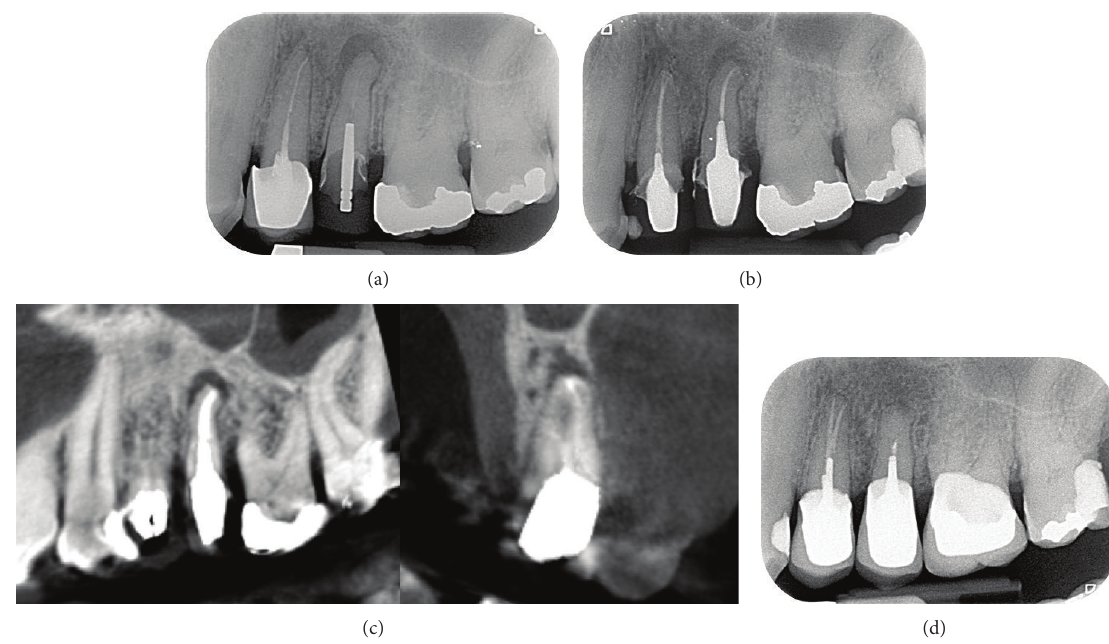
Figure 6: Contribution of the CBCT in the decision making process. (a) Periapical preoperative X-ray. Patient referred for the endodontic retreatmentof25.Notetheperiapicalradiolucencyon25.(b)Control12monthsaftertheretreatmentof25.Therearesymptomsandpersistent radiolucency on 25. The tooth was classified as “failure”. (c) CBCT coronal and sagittal slides of 25: a periapical surgery is indicated, (d) X-ray control 12 months after apical surgery and apical retrofilling with Biodentine (Septodont) which has the same radio-opacity as the root dentin.